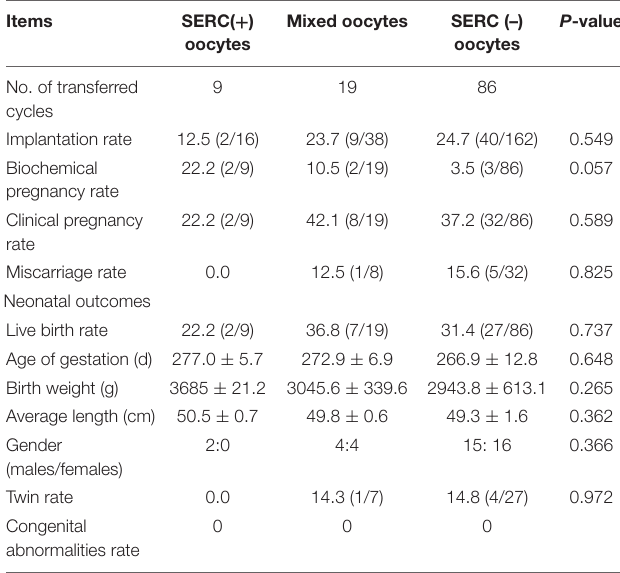
TABLE 5 | Clinical and neonatal outcomes in the transfer cycles with SERC ( + )